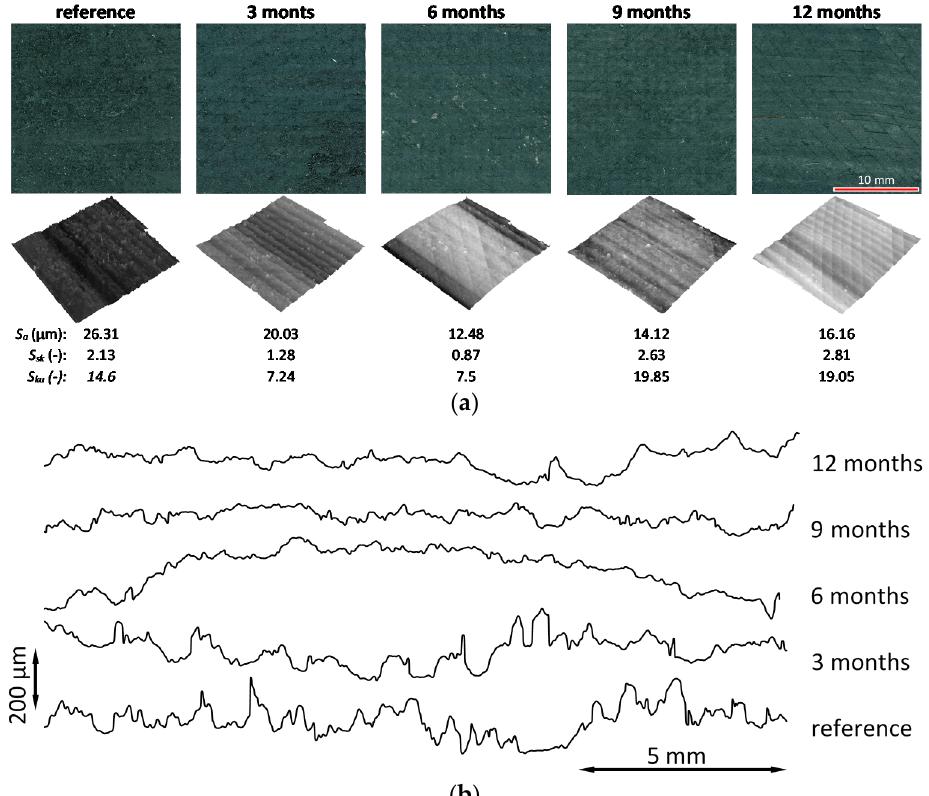
Figure 6. 3D surface topography map, typical surface profiles and high magnification images of the Scots pine wood exposed to natural weathering for 12 months, ( a ) high magnification images and 3D surface topography map, ( b ) typical surface profiles.